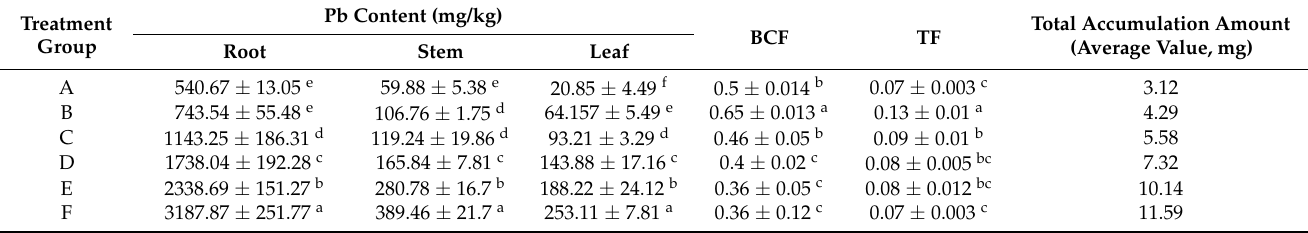
Table 3. The heavy metal content and total accumulation amount of K. paniculata under Pb